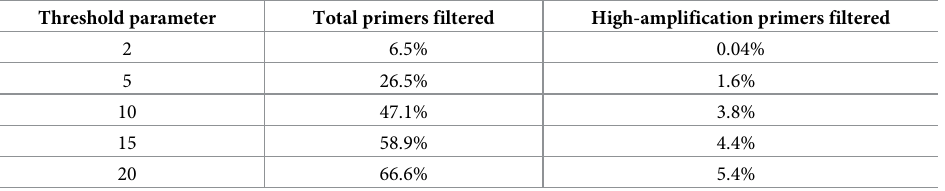
Table 4. Poor performing primers are filtered out in Stage 3 of swga2.0 . Higher threshold values in the random forest regression model filter greater proportions of lower-amplification primers but few moderate or efficient